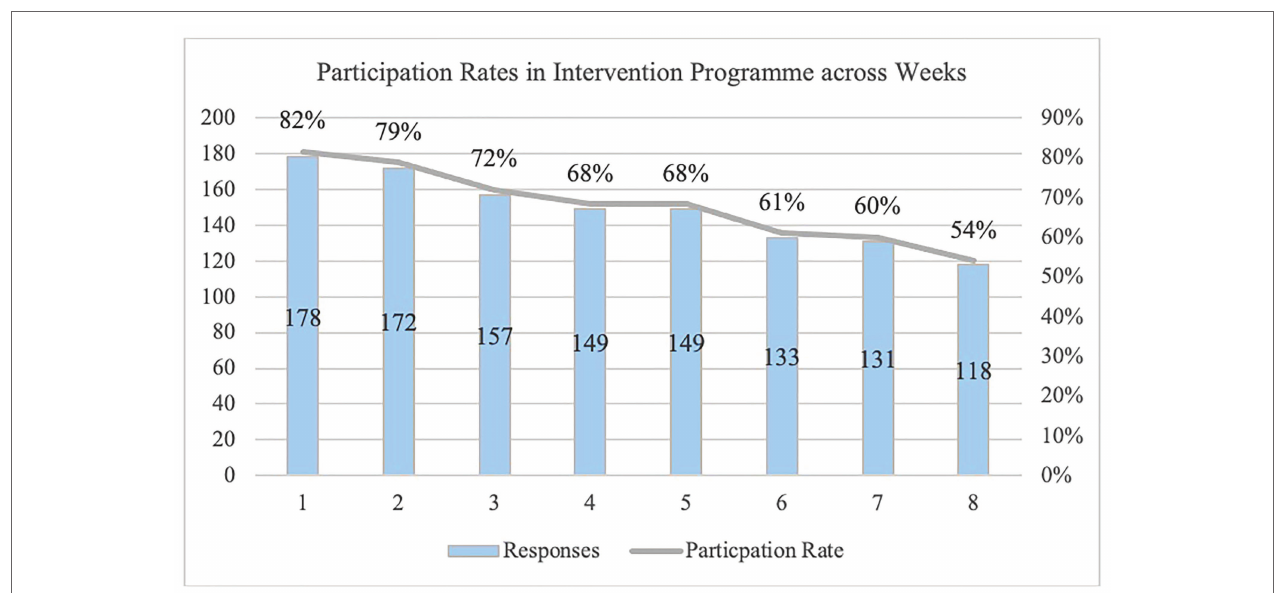
FIGURE 2 | Participation rate during the intervention